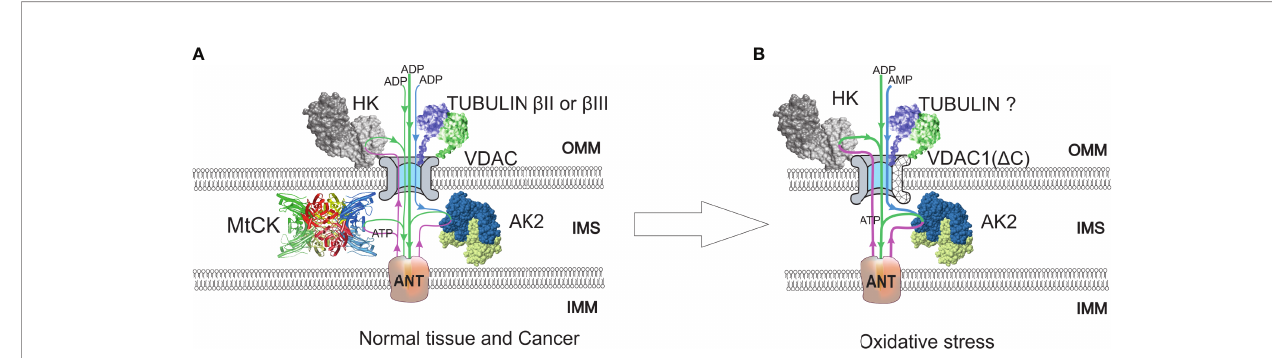
FIGURE 2 | A model of regulation of outer mitochondrial membrane (OMM) permeability for adenine nucleotides in normal and colorectal cancer (CRC) cells. Voltage-dependent anion channel (VDAC) is the pore through which adenine nucleotides move into and out of the mitochondria. (A) In normal and possibly some cancer cells, a minor amount of hexokinase (HK) is bound to VDAC and utilizes mitochondrial ATP to initiate glycolysis. Produced ADP is channeled back to the mitochondrial matrix via VDAC and adenine nucleotide translocase (ANT) for use in oxidative phosphorylation (OXPHOS). VDAC permeability is also regulated by tubulin binding. As a result of beta-tubulin-VDAC interaction, the VDAC is less permeable to adenine nucleotides. This in turn promotes cells to use creatine kinase (CK) and adenylate kinase (AK) energy transfer networks for intracellular distribution of high-energy phosphates. Mitochondrial intermembrane space (IMS)-residing mitochondrial CK (MtCK) is functionally coupled to ANT, turning OXPHOS to be dependent on ADP originating from MtCK reaction. Mitochondrial AK isoform AK2 uses AMP passing through VDAC and ATP passing through ANT to produce ADP, which stimulates OXPHOS. These energy transport systems provide feedback between ATP consumption and synthesis. (B) Redox stress may induce an increased amount of HK bound to VDAC. In addition, VDAC can be truncated at C-terminus by proteases activated in response to oxidative stress. The role of tubulin in the regulation of VDAC permeability remains unclear, as the interaction of truncated VDAC with tubulin might be impaired. The AK2 activity in cancer cells is increased, resulting in enhanced utilization of extra-mitochondrial AMP to OXPHOS. IMM, inner mitochondrial membrane; IMS, intermembrane